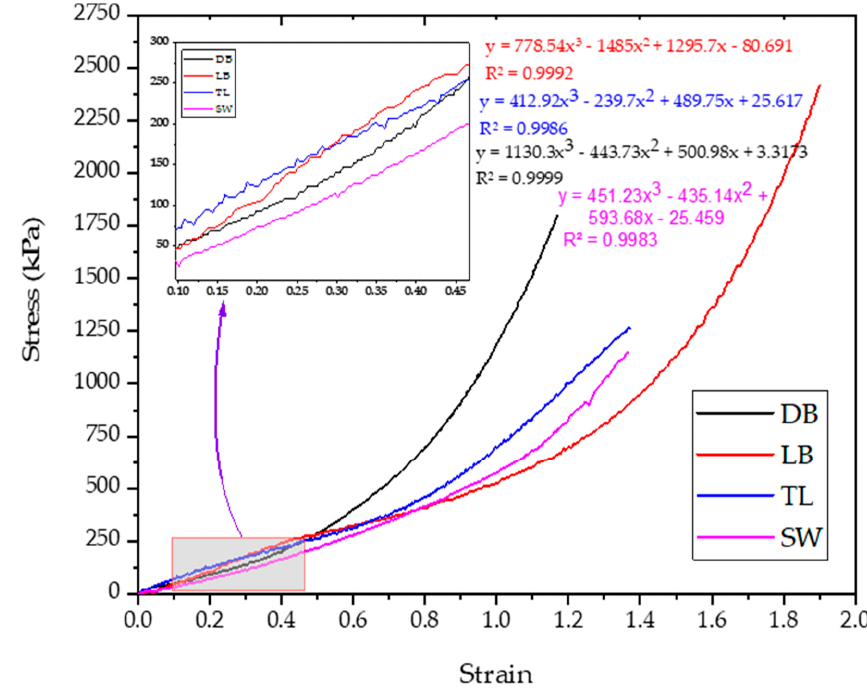
Figure 8. Stress–strain curves for the tested samples .